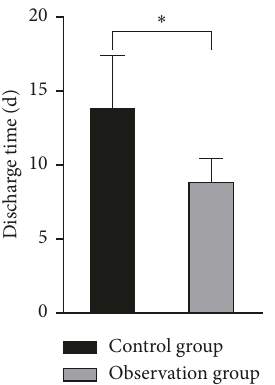
Figure 7: Comparison of the discharge time between the two groups. Note: compared with the control group,